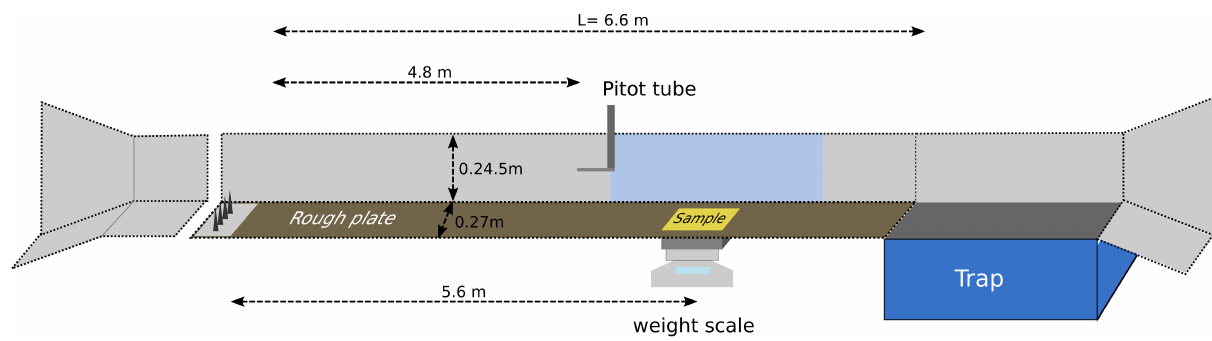
Figure 1. Schematic diagram of the wind tunnel facilities, with wind velocity measurement and weighting of the sample in time.